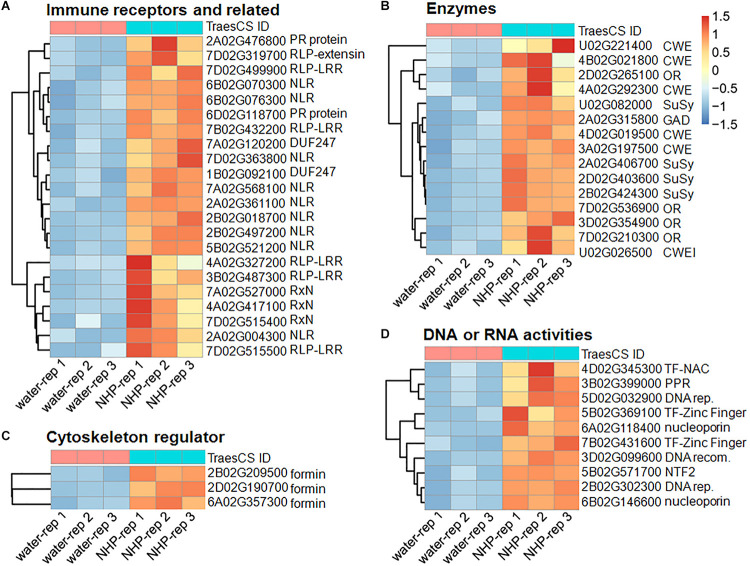
Heatmap presentation of the top 50 upregulated genes in response to N-hydroxypipecolic acid (NHP) treatment. Normalized expression data were presented. (A) Genes in group 1 and 2. (B) Genes in group 3, 4 and 5. (C) Genes in group 6. (D) Genes in group 7 and 8.